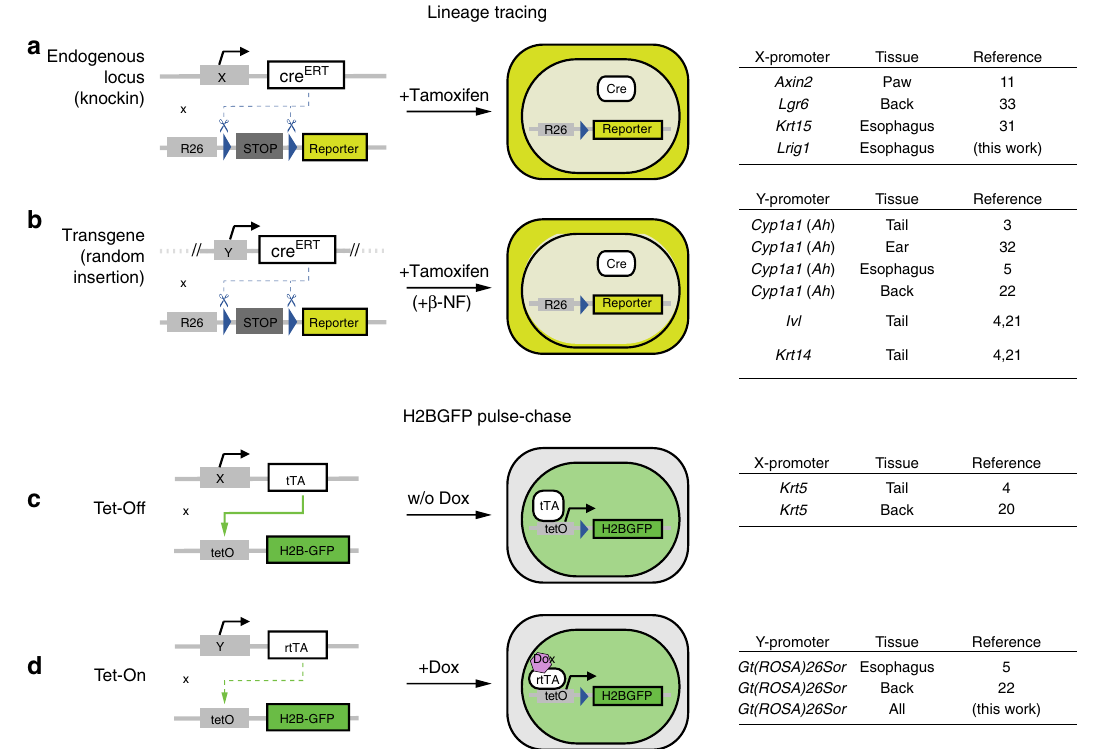
Fig. 2 Transgenic-mouse models used for lineage tracing and cell-proliferation studies. a , b Transgenic mice for lineage tracing are designed with two genetic constructs. The fi rst codes for a bacterial Cre recombinase- mutant estrogen receptor fusion protein (CreERT), which can be targeted to a speci fi c endogenous locus ( a ) or be under control of a transgenic promoter, randomly inserted in the genome ( b ). The second construct codes for a conditional fl uorescent protein reporter, typically targeted to the ubiquitously expressed Rosa26 locus. Treatment with tamoxifen induces Cre protein internalization to the nucleus, allowing expression of the reporter following Cre-mediated excision of a loxP - fl anked STOP cassette. Speci fi c details of constructs used in previous literature for lineage tracing in squamous epithelia are listed on the right. Note expression of Cre from the transgenic Cyp1a1 arylhydrocarbon receptor, Ah ) promoter requires additional treatment with a Ah inducer, β -naptho fl avone ( β -NF). c , d Transgenic mice for H2BGFP-dilution experiments are designed with a fi rst construct, typically targeted to a constitutive promoter, coding either for a tetracycline-controlled transactivator (tTA; Tet-Off